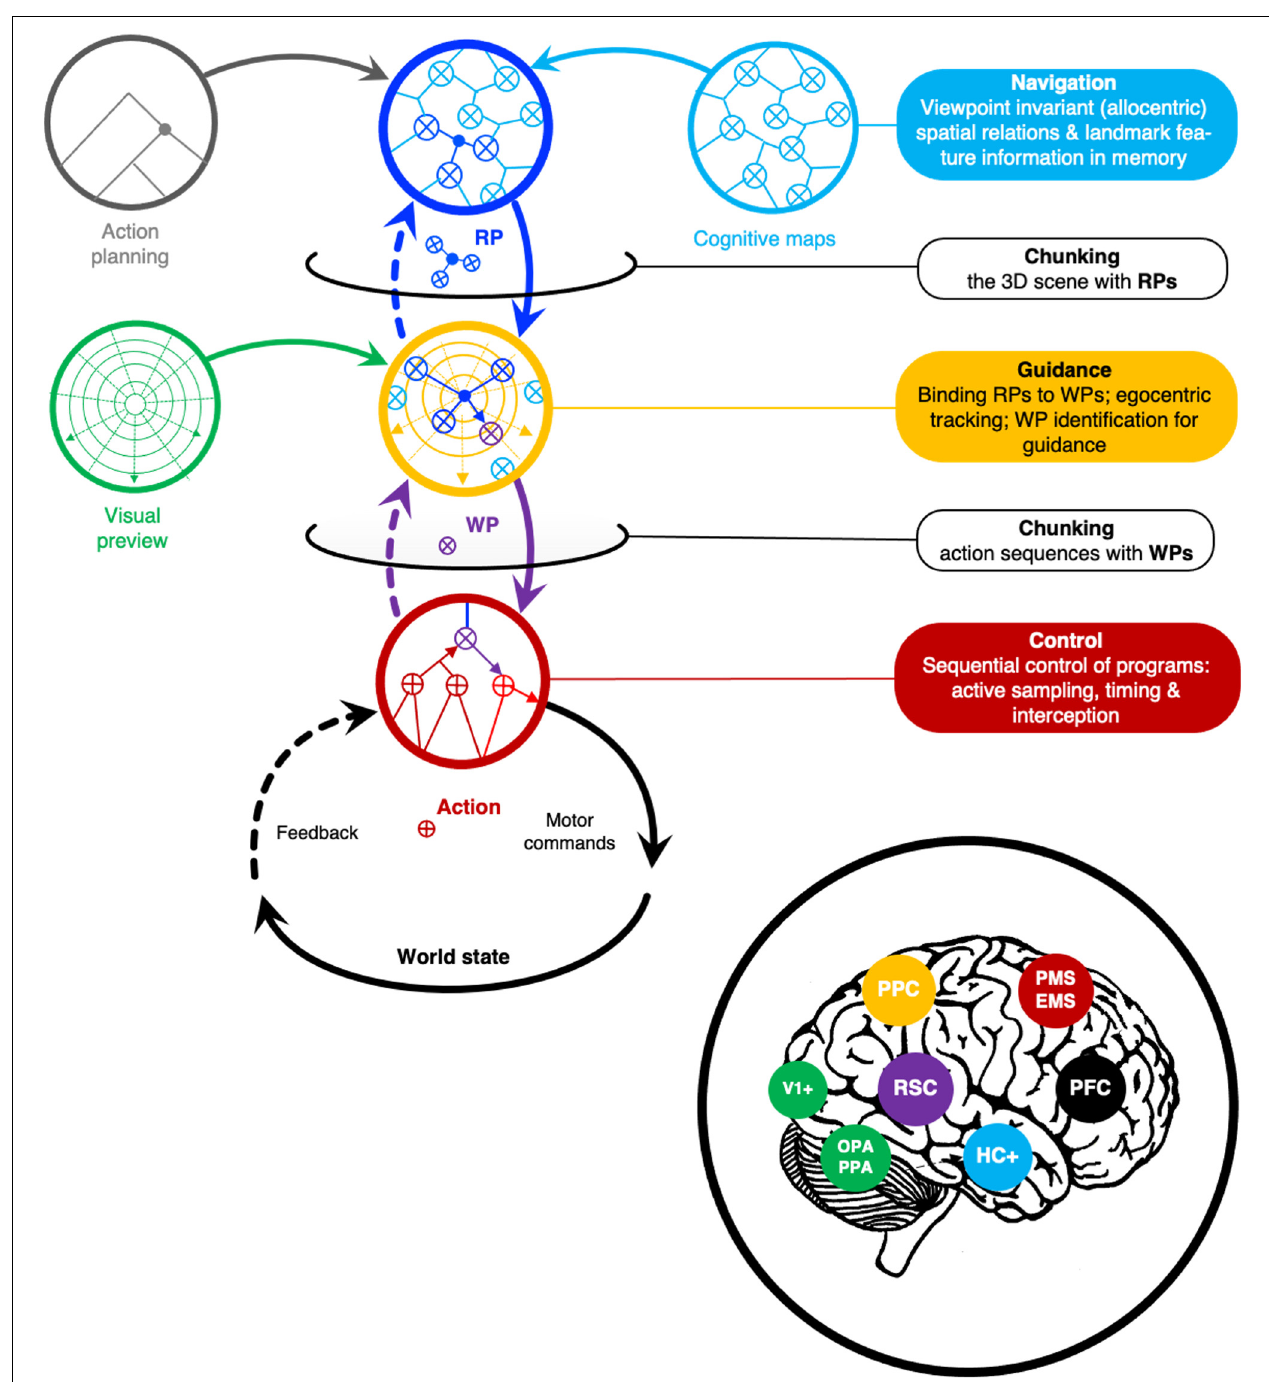
FIGURE 6 | Main picture. Egocentric chunking as cognitive processes operating on representations at different levels of the hierarchy, in different coordinate systems, and at different spatial and temporal scales. Each level deals with different aspects of wayfinding and visual guidance (only). The core process is chunking WP and RP information at the guidance level. Waypoints are identified top-down by their association with visually identified scene elements (reference points in the cognitive map), but their precise egocentric positioning also depends on the preview of scene layout and bottom-up information (efference copy and integrated multisensory perceptual feedback from the control level). they are fixed “on the fly”. RP, reference point information. WP waypoint information. See also Table 2 . Inset : Key nodes in the wayfinding networks (see Figure 7 ). HC+, hippocampal “cognitive map” system; PFC, prefrontal cortex; PPC, posterior parietal cortex; PMC, premotor cortex; PMS, EMS, pyramidal and extrapyramidal motor systems; OPA, PPA, occipital and parahippocampal place areas; MST, middle superior temporal, V5/MT; RSC, retrosplenial complex. The color-coding indicates the suggested mapping of the cognitive processes onto the network.